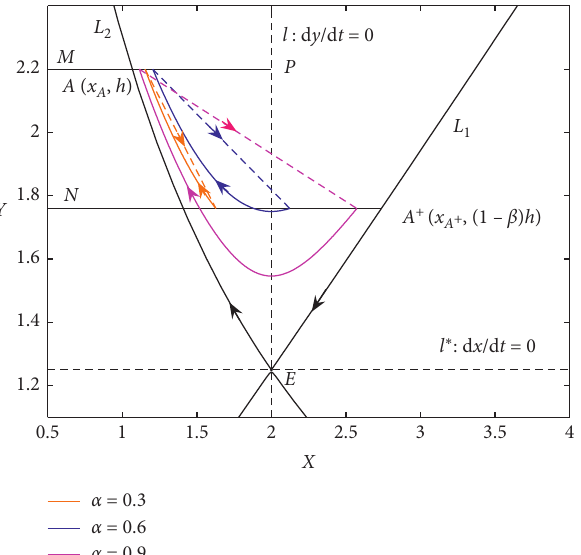
Figure 10: Existence of order-1 periodic solution when α < 1 with parameter values: a � 5 ,c � 4 , d � 6 , e � 3 ,h � 2 . 2 , and β � 0 . 2 and initial values ( 3 . 5 , 2 . 4 ) . The cases of α � 0 . 3, α � 0 . 6, and α � 0 . 9 are shown with hazel, blue, and pink lines